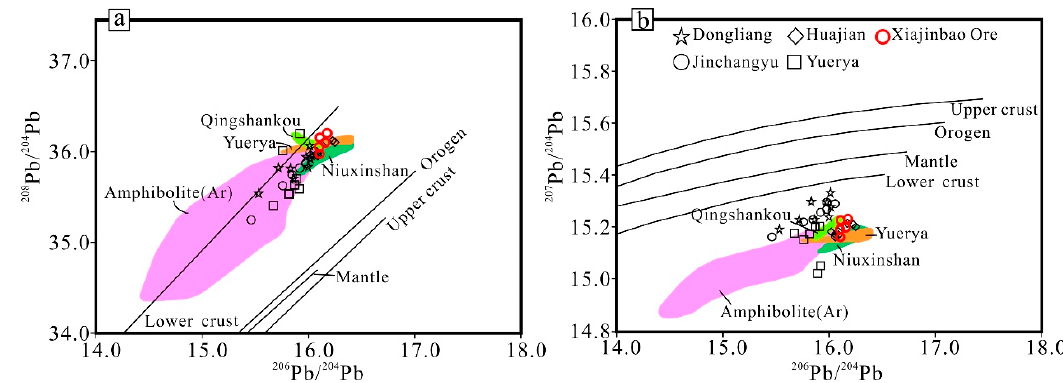
Figure 14. Diagram showing 208 Pb/ 204 Pb vs. 206 Pb/ 204 Pb ( a ) abd 207 Pb/ 204 Pb vs. 206 Pb/ 204 Pb ( b ) of sulfides and granitic rocks from the Jidong area, Modified from Zartman et al. [40]. Lead isotope data of the Huajian deposit are taken from Wang [41]; Lead isotope data of the Dongliang deposit are from Xin et al. [42]; Lead isotope data of the Jinchangyu deposit are from Lin and Guo [43]; Lead isotope data of the Yuerya deposit are from Chappell [44]; Lead isotope data of the Archean plagioclase hornblende gneiss are from Lin and Guo [43], respectively.